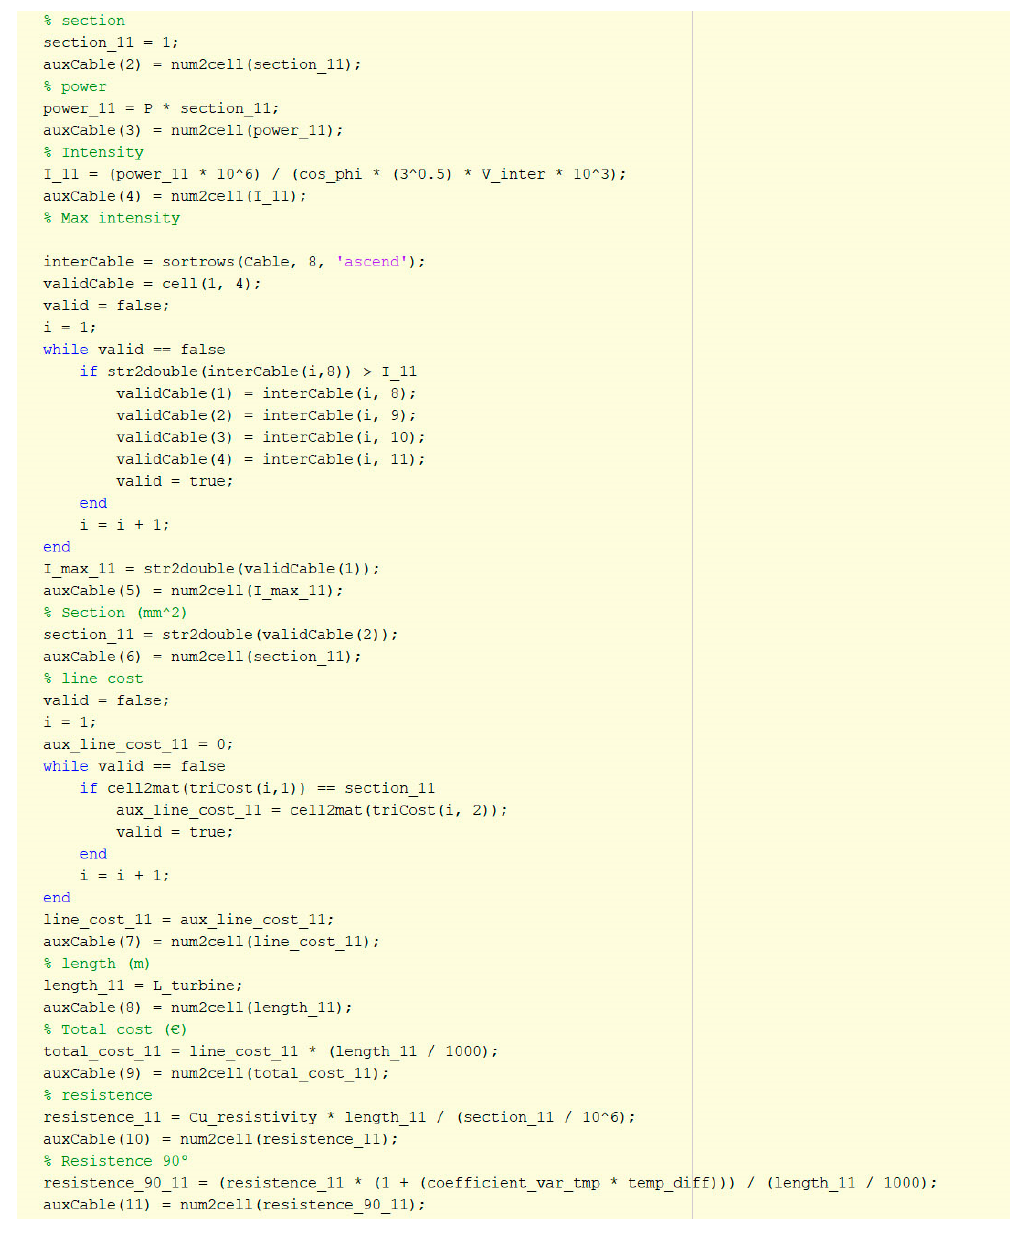
Figure A1. Example of the software code.